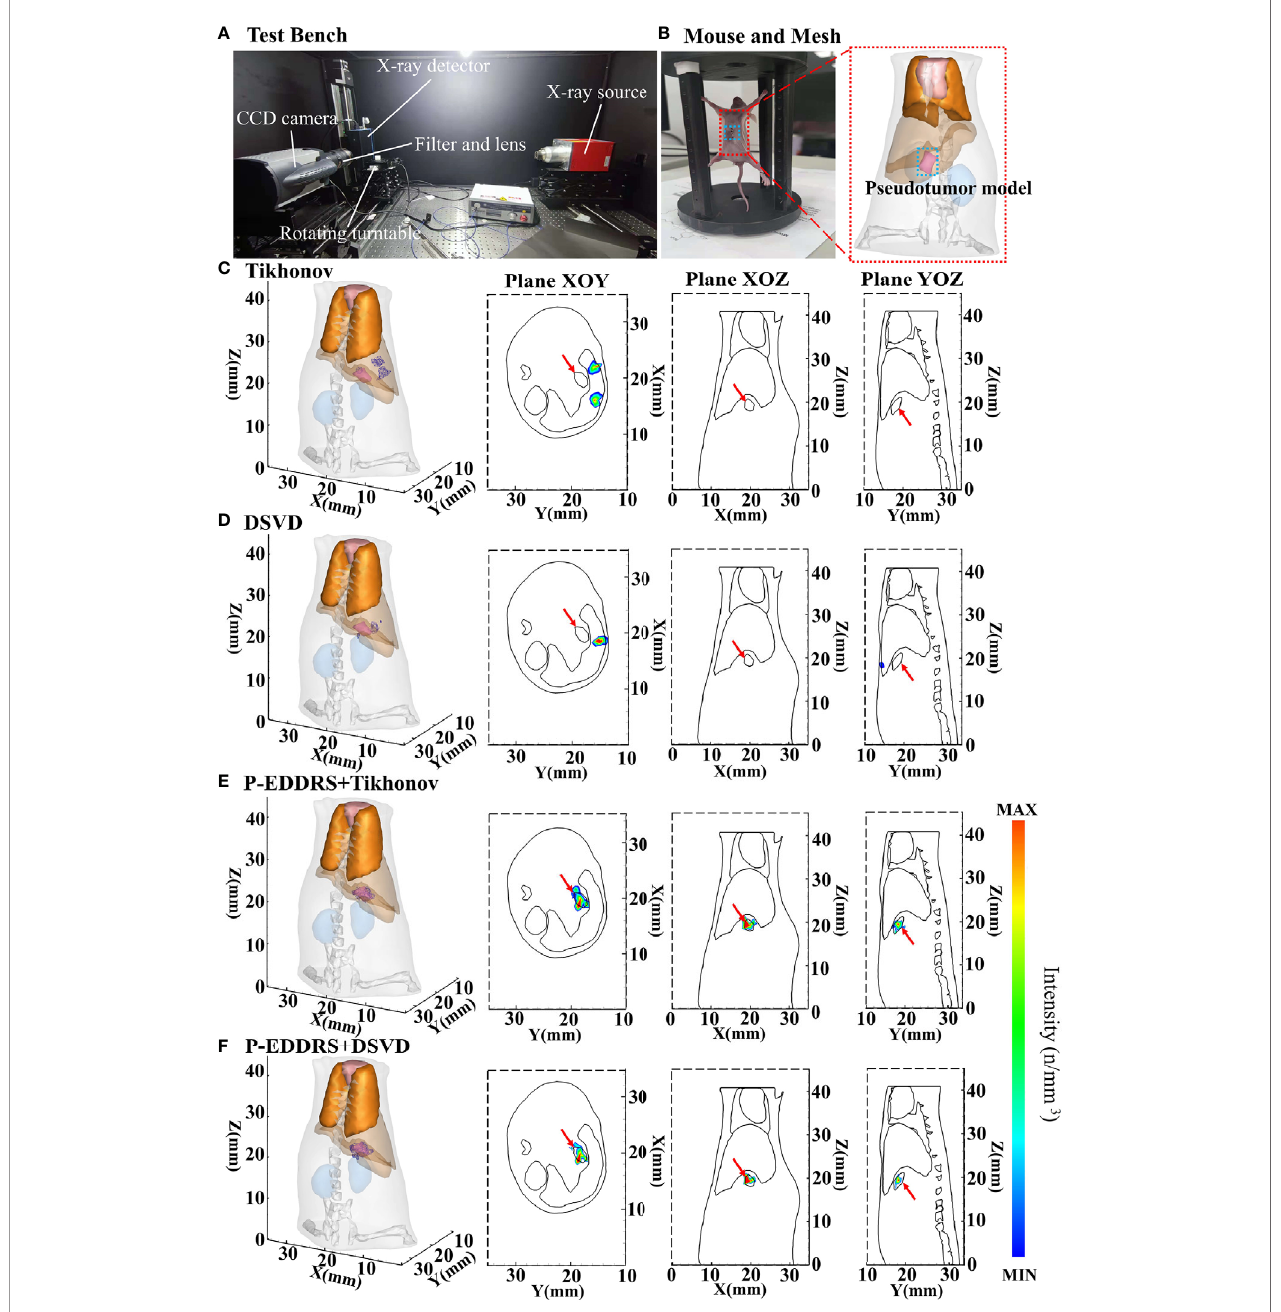
FIGURE 8 | Results of the CLT in vivo pseudotumor experiments. All results include 3D views and corresponding cross-section views at the Z = 19.2 mm, Y = 18.4 mm, and X = 19.68 mm. (A) Picture of the test bench where the data were collected. (B) The mouse used, and the dashed box is the pseudotumor model planting area. (C, D) The initial reconstruction source distribution of Tikhonov and DSVD algorithms, respectively. (E, F) The reconstruction source distribution obtained by the corresponding algorithms of panels (C, D) after using our framework. CLT, Cerenkov luminescence tomography; DSVD, damped singular value